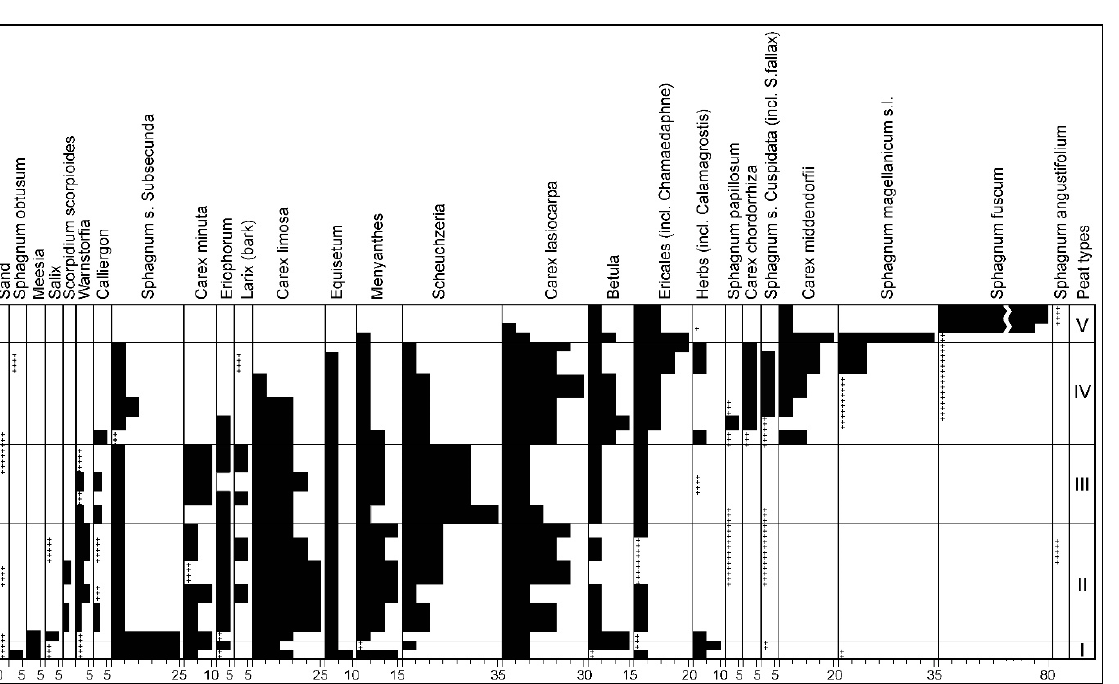
Figure 6. Botanical composition of peat under flark (only the upper 2 m sampled). Peat types: I— eutrophic Scheuchzeria -sedge, II—eutrophic sedge-sphagnum and III—eutrophic sedge. 4. Discussion The mires studied correspond to the term of aapa mires in topology, surface pattern, botanical composition and stratigraphy of deposit [7]. For the territory of the Amur River region, mires had not been studied previously. For the region, the most typical are ridge-hollow (-pool) raised bogs, which combine complex oligotrophic fractions of Sphagnum magellanicum s.l. and S. papillosum in the cen- tral areas. Minerotrophic species are absent. Closer in terms of vegetation are the quite unique complex string-flark (shallow gully) fens, in which the strings and flarks are di- rected along the runoff stream [38–40]. In particular, similar complexes to these consist of the stretched twisty strings and path-shaped depressions between them. They are marked as some of the most spread on the right bank area of the Amur in the central parts of mari mires [38]. Their strings are dwarf shrub-herb with Carex lasiocarpa , Sphagnum magellan- icum and S. imbricatum, less frequent are S. angustifolium , S. fuscum, andtheflarks are with